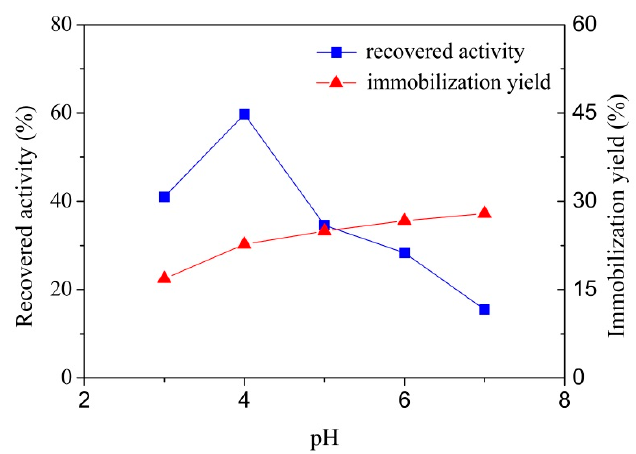
Figure 3. Effect of pH on immobilized laccase recovered activity and laccase immobilization yield by adsorption on MCCBs.